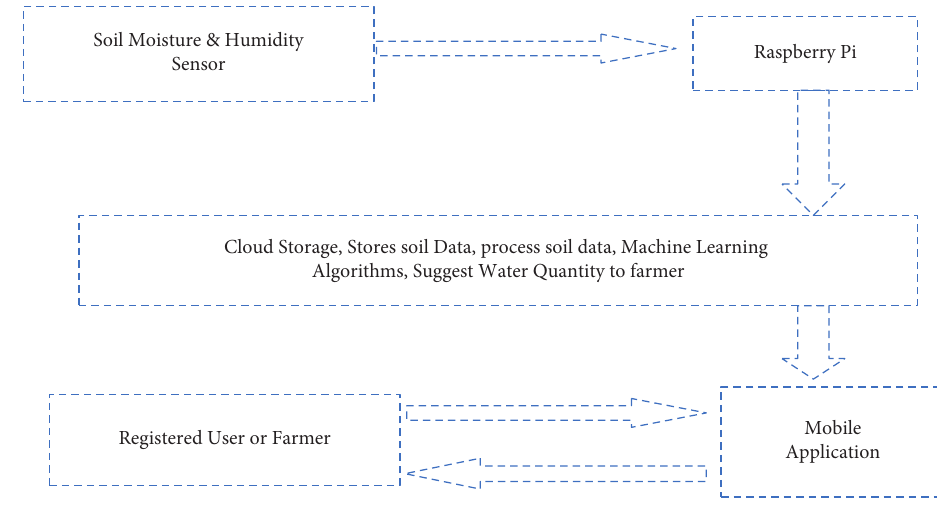
Figure 2: A framework for smart